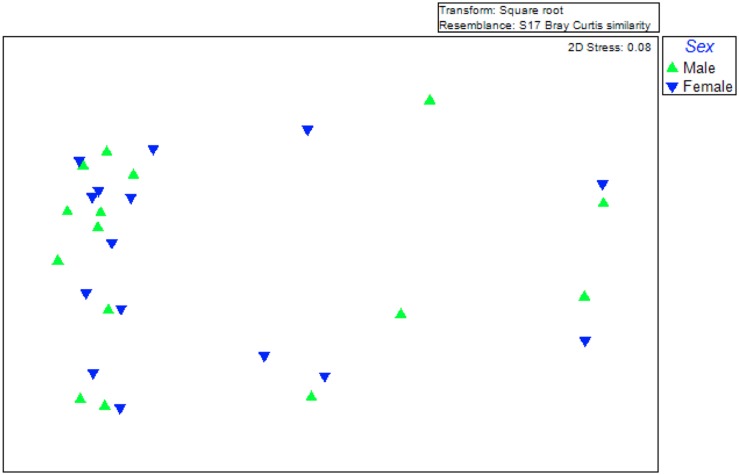
Multidimensional scaling (MDS) plot for a graphical illustration of changes in the bacterial community structure. Green triangles represent males while inverted blue triangles represent females. Similarities in ribotype profiles were calculated by the Brey-Curtis algorithm.